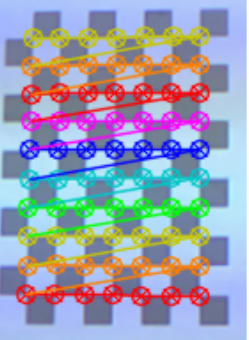
Figure 2 – Photo of calibration on a standard chessboard.